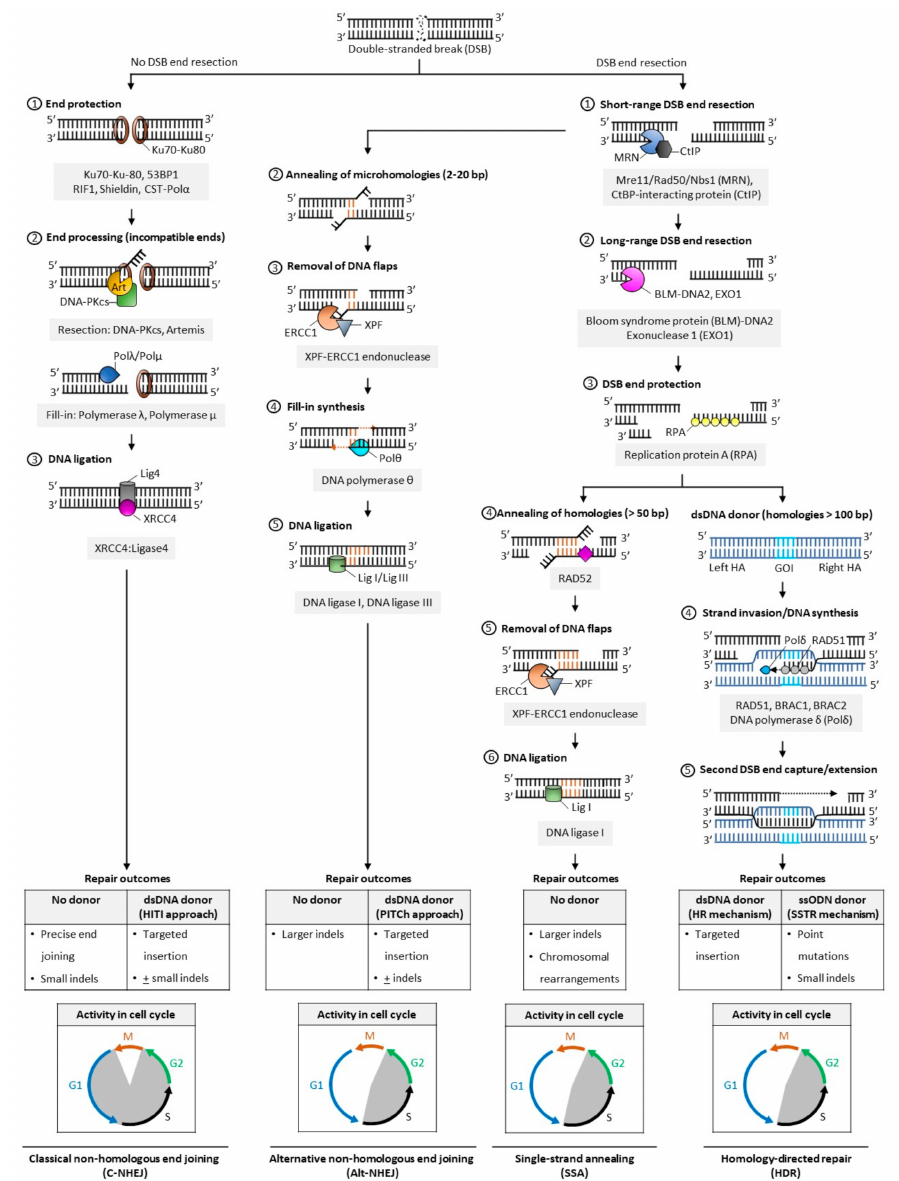
Figure 2. Pathways of DNA double-stranded break repair. Double-stranded breaks (DSBs) are introduced by engineered nucleases at the chosen genomic locus to stimulate endogenous cellular DNA repair mechanisms and promote various repair outcomes. In mammalian cells, DNA DSBs are repaired by classical non-homologous end-joining (C-NHEJ), alternative non-homologous end-joining (alt-NHEJ, also known as MMEJ), single strand annealing (SSA), or homology-directed repair (HDR) pathways. In the absence of donor templates, precise end joining, insertions and deletions (indels), and chromosomal rearrangements may be observed. Addition of a donor DNA template during repair can be used to install and correct point mutations, or knock-in larger DNA sequences. Classic NHEJ does not require template DNA and is the primary repair pathway in cells, whereas alt-NHEJ, SSA, and HDR are known to be active during the S and G2 phases of the cell cycle. Abbreviations: 53BP1: p53-binding protein 1; bp: base pairs; BRAC1: breast cancer type 1; BRAC2: breast cancer type 2; CtBP: C-terminal binding protein; DNA-PKcs: DNA-dependent protein kinase, catalytic subunit; dsDNA: double-stranded DNA; ERCC1: excision repair cross-complementation group 1; GOI: gene of interest; Mre11: meiotic recombination 11; Nbs1: Nijmegen breakage syndrome 1; RAD50/51/52: radiation sensitive 50/51/52; RIF1: Ras relate protein (Rap)- interacting factor 1; CST-Pol α : CTC1-STN1-TEN1 (CST)-Polymerase α ; HITI: homology-independent targeted insertion; HR: homologous recombination; indels: insertion and deletion; PITCh: precise integration into target chromosome; ssODN: single-strand oligodeoxynucleotide; SSTR: single strand template repair; XPF: xeroderma pigmentosum complementation group F; XRCC4: X-ray repair cross completing protein